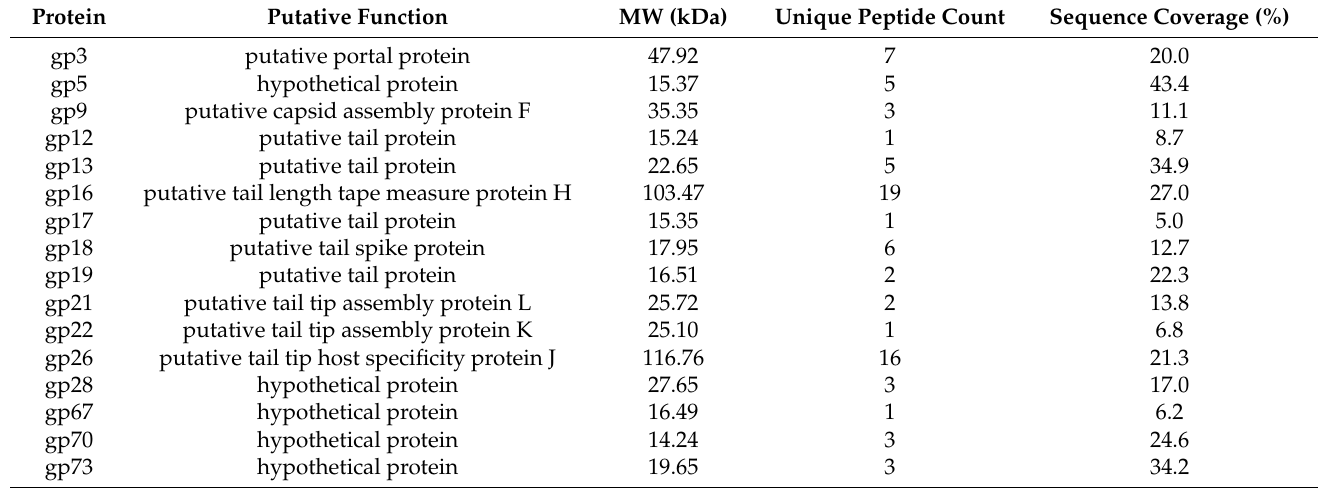
Table 1. Structural proteins of CUB19. Sixteen proteins were identified by ESI-LC-MS/MS as being part of the CUB19 virion. For every protein, the molecular weight (MW), the unique peptide count and the protein sequence coverage is provided.